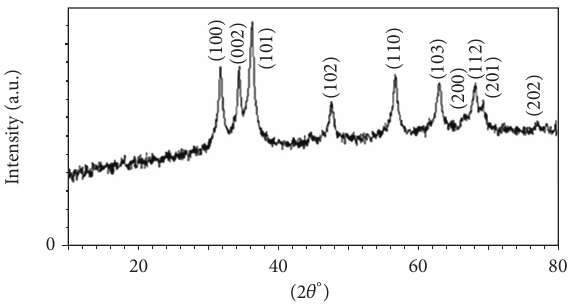
F 1: XRD pattern of as-prepared ZnO nanoparticles.